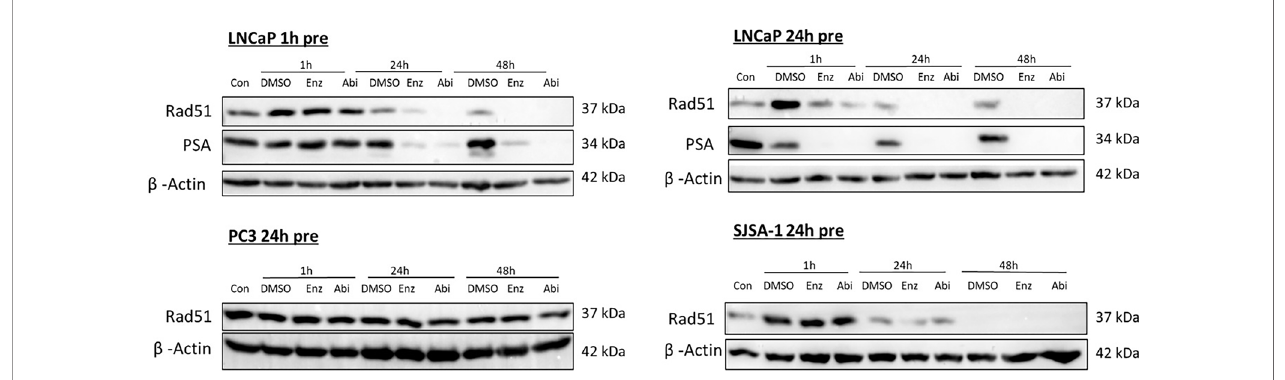
FIGURE 8 | Impact of Abiraterone and Enzalutamide in combination with 2 Gy X-ray on RAD51 and PSA expression in AR-insensitive PC3s and AR-sensitive LNCaP prostate models and osteoblastic bone model SJSA-1. All models were treated with 10 m M Abiraterone, Enzalutamide or DMSO 1 or 24 hours before radiation. Samples were then harvested 1, 24 and 48 hours post-radiation and expression levels measured via Western blot. b -Actin was used as a loading control. (n=3).